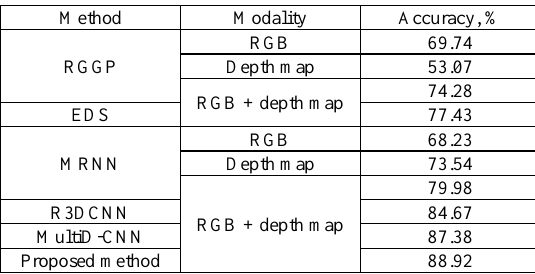
Table 2. Comparison table of the proposed method with other